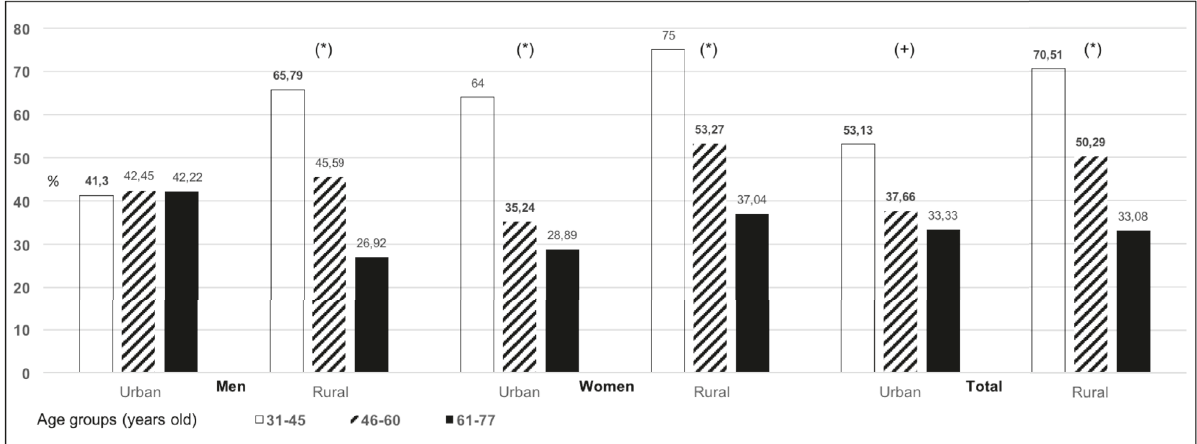
Figure 1: Prevalence of controlled blood pressure in hypertensive subjects according to the age group and living area . ( ∗ ) Overall age categoriescomparisonp < .001(+).Overallagecategoriescomparisonp=.004. Comparatives: 31to45year-oldurbanversusruralmen ( 41.30 versus 65.79 % , p=.025 ), 31 to 45 year-old urban versus rural women (64.00 versus 75.00 %, p=.263), 31 to 45 year-old urban versus rural subjects ( 53.13 versus 70.51 % , p=.019 ), 46 to 60 year-old urban versus rural men (42.45 versus 45.59 %, p=.684), 46 to 60 year-old urban versus rural women (35.24 versus 53.27 % , p=.002), 46 to 60 year-old urban versus rural subjects ( 37.66 versus 50.29 % , p=.002 ), 61 to 77 year-old urban versus rural men (42.22 versus 26.92 %, p=.113), 61 to 77 year-old urban versus rural women (28.89 versus 37.04 %, p=.257), 61 to 77 year-old urban versus rural subjects (33.33 versus 33.08 %, p=.965). Statistically significant values are highlighted in bold